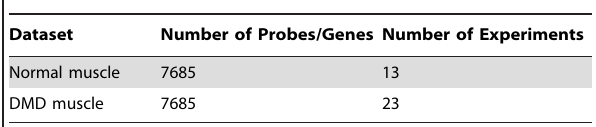
Table 11. Summary of pre-processed GSE6011 dataset